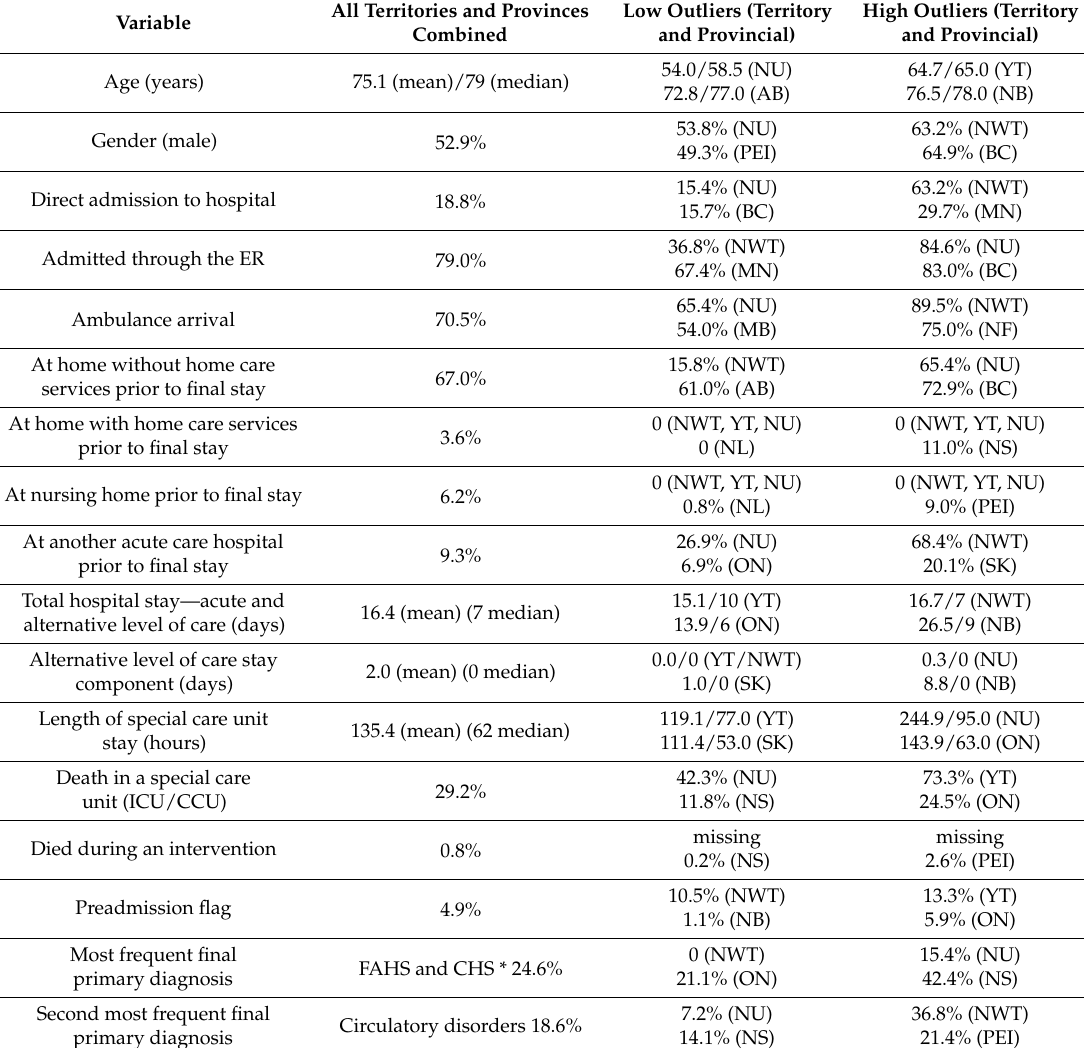
Table 2. Decedent final stay hospital utilization and patient characteristics